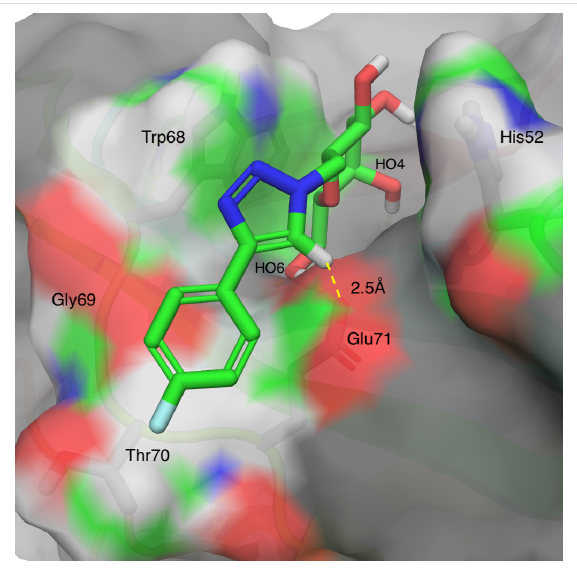
Figure 1: Galectin-1 in complex with 1b derived by energy-minimizing a representative snapshot from a 200 ns molecular dynamic simula- tion. The distance between the triazole hydrogen and the Glu71 carboxylate is depicted with a yellow dashed line. The image was generated using PyMOL v1.7 (Schrodinger